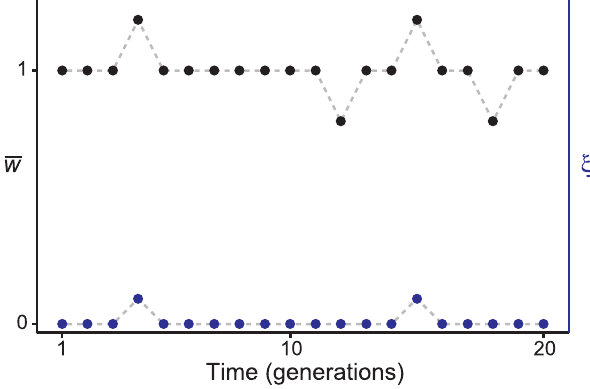
Figure 4. Hypothetical example of a local population in which { immigration ( j ) and within deme mean reproductive rate ( w ) vary over time. j ~ 0 with probability 0.9 and j ~ : 1 with probability { { w ~ 1 with probability 0.8, w ~ 0 : 7 with probability 0.1, and 0.1, and { w ~ 1 : 3 with probability 0.1. In this case, b jj ~ 0 : 01 and SS 2 j TT ~ 0 : 0009 . { w . If immigration were Emigration is independent of both j and { w and of emigration, then the effective migration rate independent of is m e ~ 0 : 0091 . If, however, immigration and within deme reproduction are strongly correlated, so that immigrants always arrive during times of { w , j TT ~ 0 : 003 , high within deme reproduction (as illustrated), then SS so m e ~ 0 : 0061 .